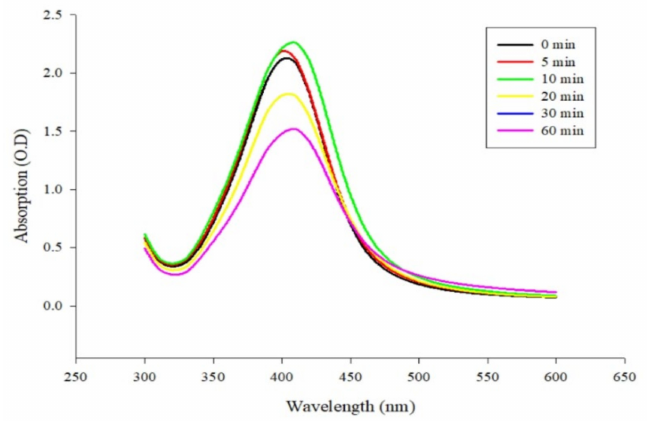
Figure 3. The ultraviolet-visible absorption spectrum of silver nanoparticles (AgNPs) was synthesized by reducing silver ions with trisodium citrate (SC) for 0 to 60 min (0, 5, 10, 20, 30, and 60 min). Then sodium borohydride was added to the silver nitrate-trisodium citrate solution and kept stirring for 120